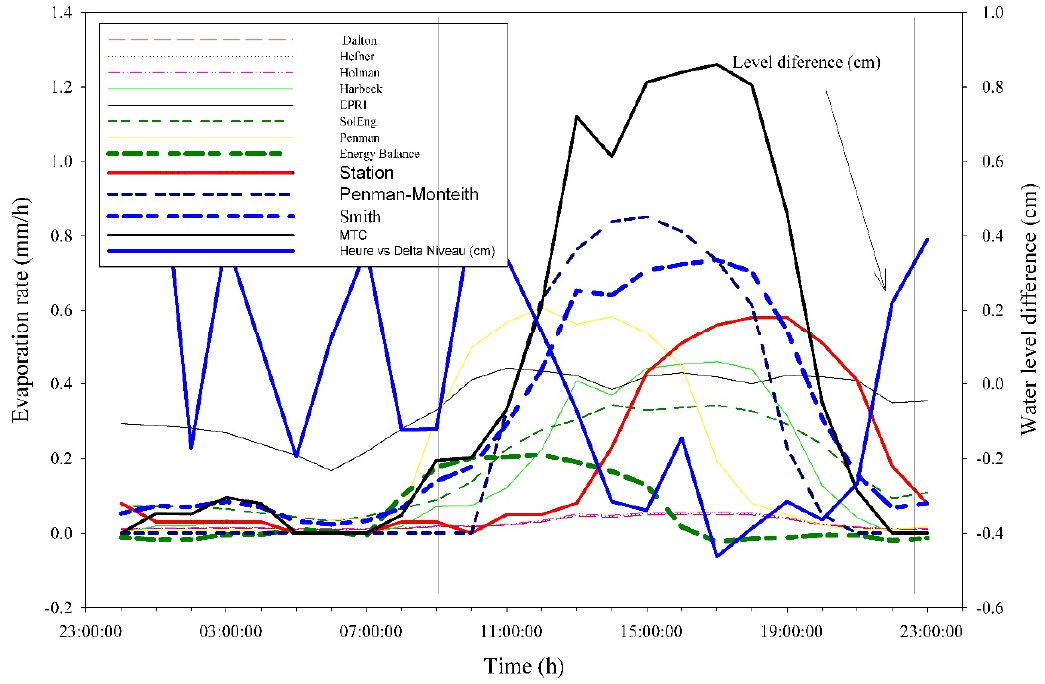
Figure 11. Evaporation rate on 2 August 2018 by different methods from Thomas Pond.